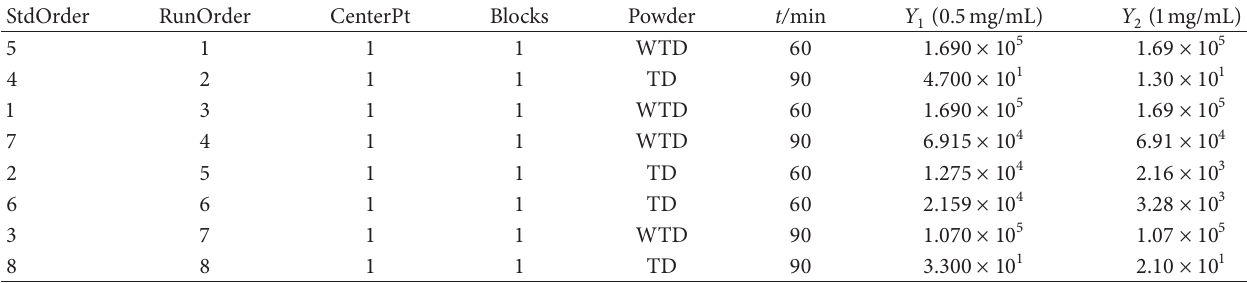
Table 1: Experimental data entered for the experimental design run.